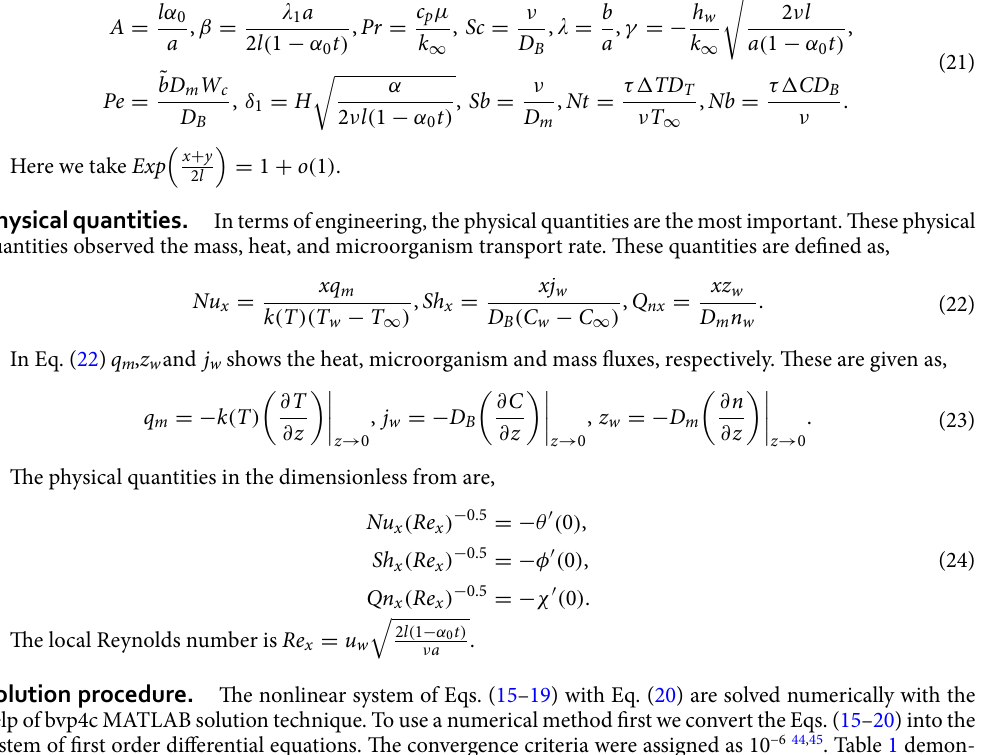
symbols Nb , Pe , Nt and Sb denotes Brownian motion parameter, Peclet number, the thermophoresis parameter and bio-convection Schmidt number respectively. These parameters are defined as,